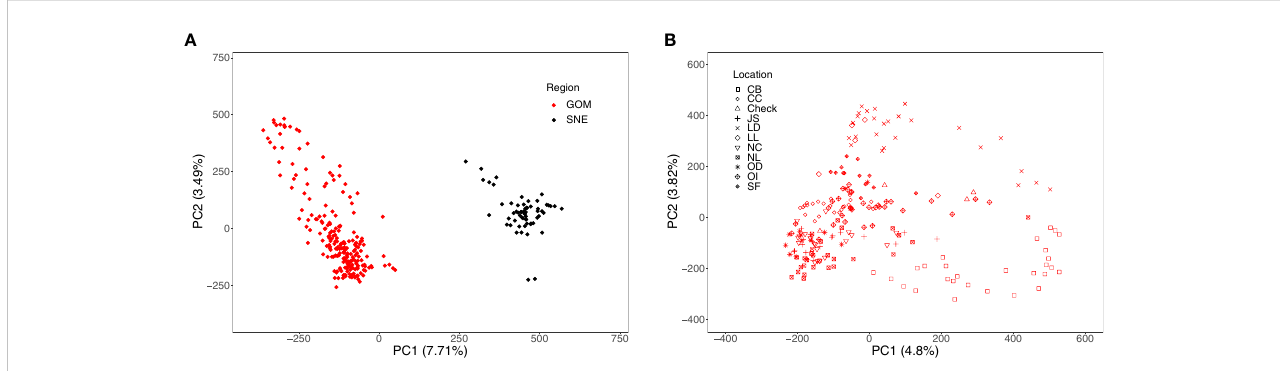
FIGURE 1 (A) Principal Component Analysis (PCA) for 276 GPs using 909,749 SNPs. Red symbols: Gulf of Maine (GOM), black symbols: Southern New England (SNE). (B) PCA for GPs within the GOM region. These gametophytes came from parents collected from the following locations: CB, Casco Bay farm ( n = 28); CC, Cape Cod canal ( n = 23); Check, gametophytes came from GOM checks crosses ( n = 4); JS, Fort Stark ( n = 22); LD, Lubec Dock ( n = 27); LL, Lubec Light ( n = 5); NC, New Castle ( n = 19); NL, Nubble Light ( n = 28); OD, Outer Dock ( n = 11); OI, Orr ’ s Island ( n = 32); and SF, Sullivan Falls ( n = 14).